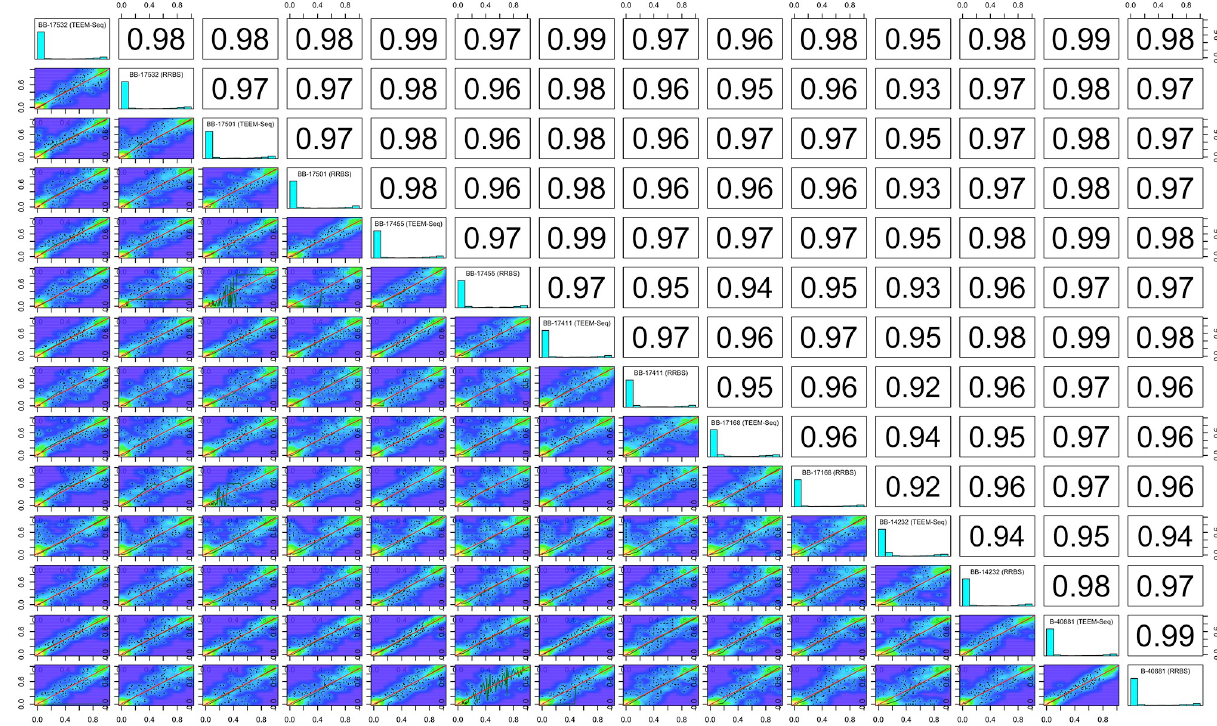
Fig 4. Putative promoter target region CpG site-level percent DNA methylation distribution histograms for each sample library and scatterplots with Pearson correlation coefficients between target-enriched enzymatic methyl sequencing (TEEM-Seq) and reduced-representation bisulfite sequencing (RRBS) libraries from the same individual superb starlings. CpG sites shared between TEEM-Seq and RRBS libraries at 5x coverage or above (1,390 CpG sites shared across all seven samples) were used for paired comparisons with the getCorrelation function in methylKit for superb starling individuals BB-17532, BB-17501, BB-17455, BB-17411, BB-17168, BB-14232, and B-40881. Blue regions of the scatterplots are uncorrelated, yellow regions are highly correlated, and green regions are variably correlated. The green lines represents lowess polynomial regression fits, whereas the red lines represent linear regression